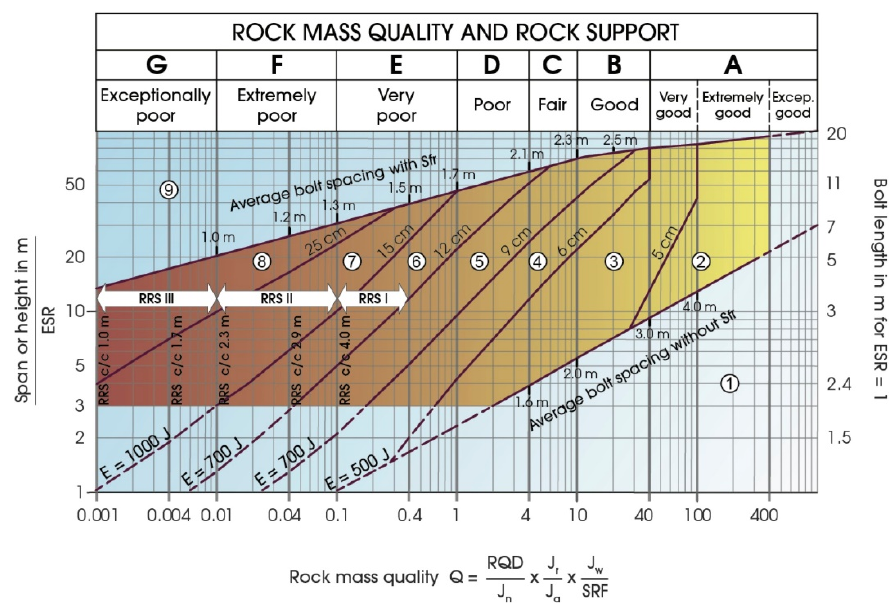
Figure 1. The Q-system for design of rock support; from Grimstad et al. [24].